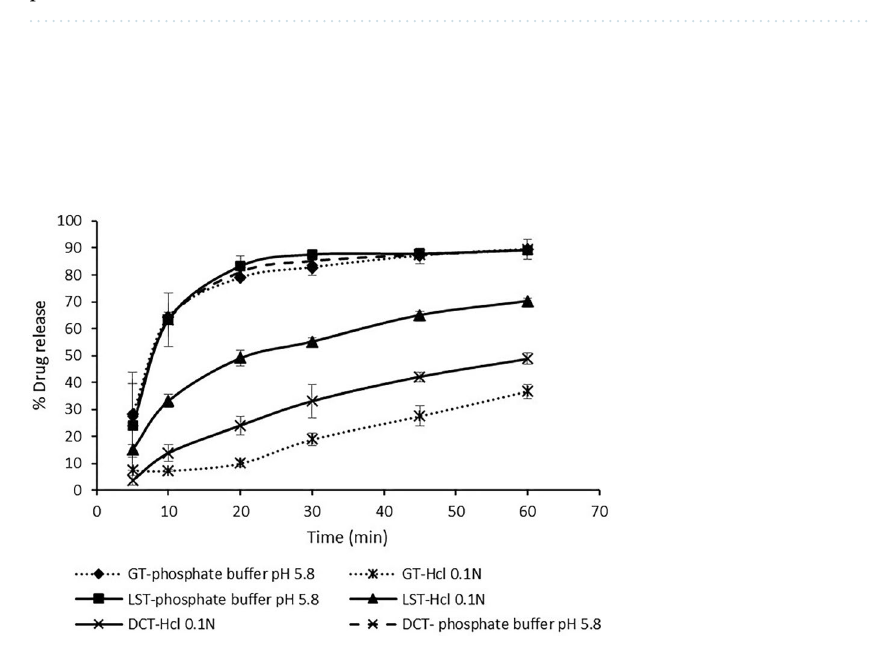
Figure 6. SEM images of (A) Aerosil 200, 1000x. (B) Avicel PH101, 1000x. (C) LS powder, 1000x, (D) LS powder, 2000x.